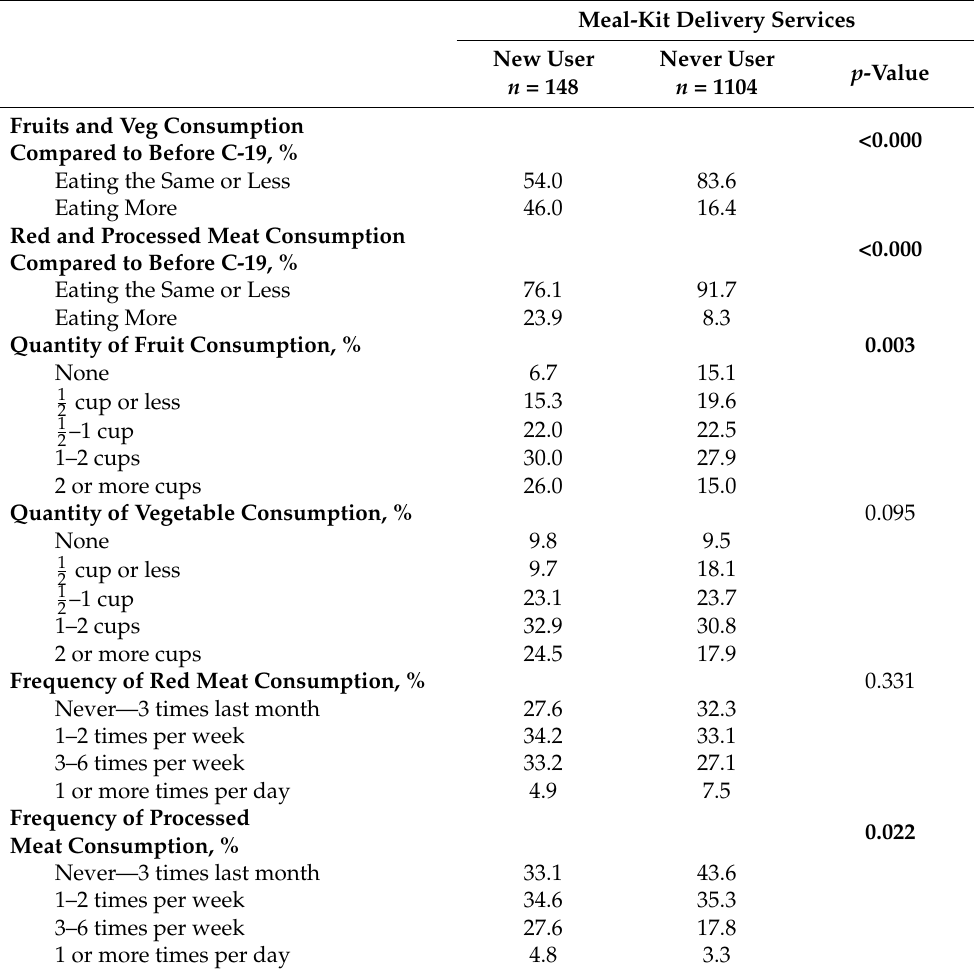
Table 2. Weighted Distribution of Reported Dietary Behaviors Among Never Users and New Users of Meal-Kit Delivery Services During the Early Months of COVID-19 Pandemic: Results from the National Food Access and COVID Research